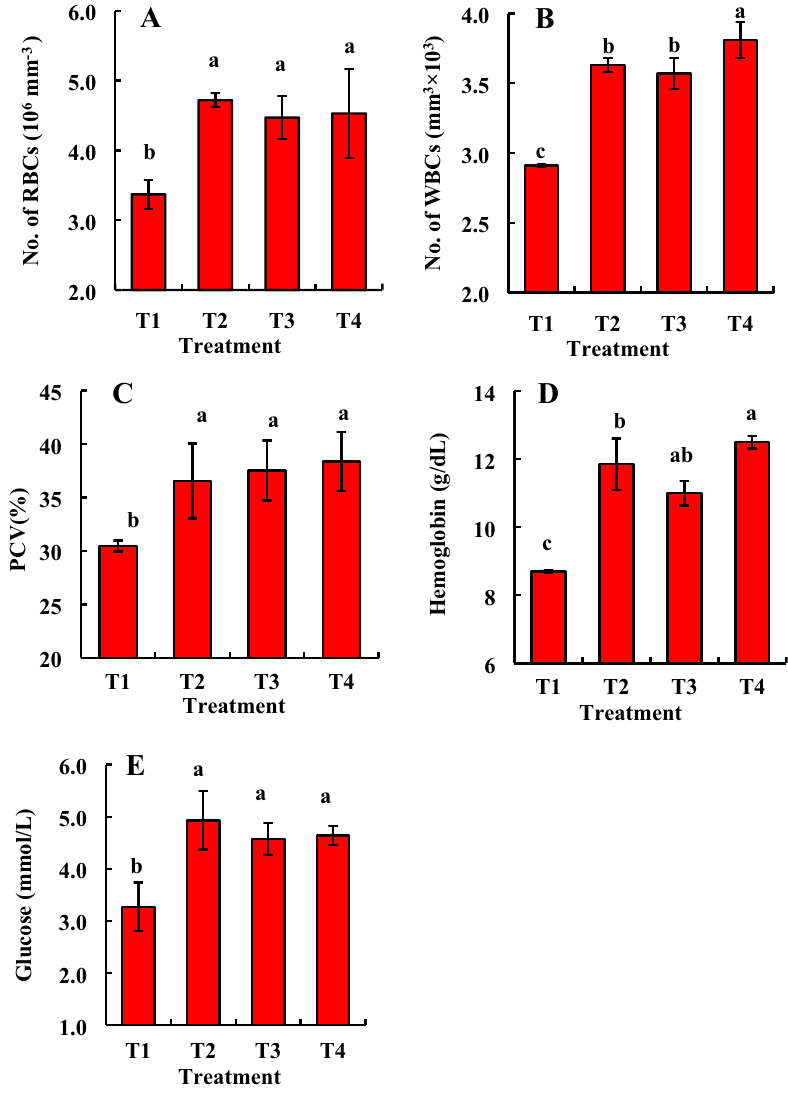
Figure 7. Assessment of consortium effects of bacterial probiotic strains viz . GFB-1, GFB-2, GFB-3, GFB-4 and GFB-5 isolated from the gut of B. gonionotus on hematological parameters (A, B, C, D and E) of the host fish. Blood was collected from nine fishes of each replication and 27 fishes of each treatment for estimating (A) red blood cell (RBC), (B) white blood cell (WBC), (C) packed cell volume (PCV), (D) hemoglobin level and (E) glucose level. One way ANOVA was performed for analyzing the data of three replicated experiment and data in column varies significantly in LSD at P < 0.05 (Statistix 10). Different letter bars indicate significant variations in RBC, WBC, PCV (%), hemoglobin and glucose level of the host fishes in different groups by the isolates at P < 0.05 (Statistix 10). Error bar = ± SD; n = 27. R 2 values are as follows: RBC = T1 (Control) (0.642), T2 (0.671), T3 (0.642), and T4 (0.997); WBC = T1 (Control) (0.712), T2 (0.738), T3 (0.976), and T4 (0.783); PCV = T1 (Control) (0.846), T2 (0.630), T3 (0.750), and T4 (0.629); Hemoglobin = T1 (Control) (0.977), T2 (0.713), T3 (0.929), and T4 (0.789); Glucose = T1 (Control) (0.803), T2 (0.635), T3 (0.724), and T4